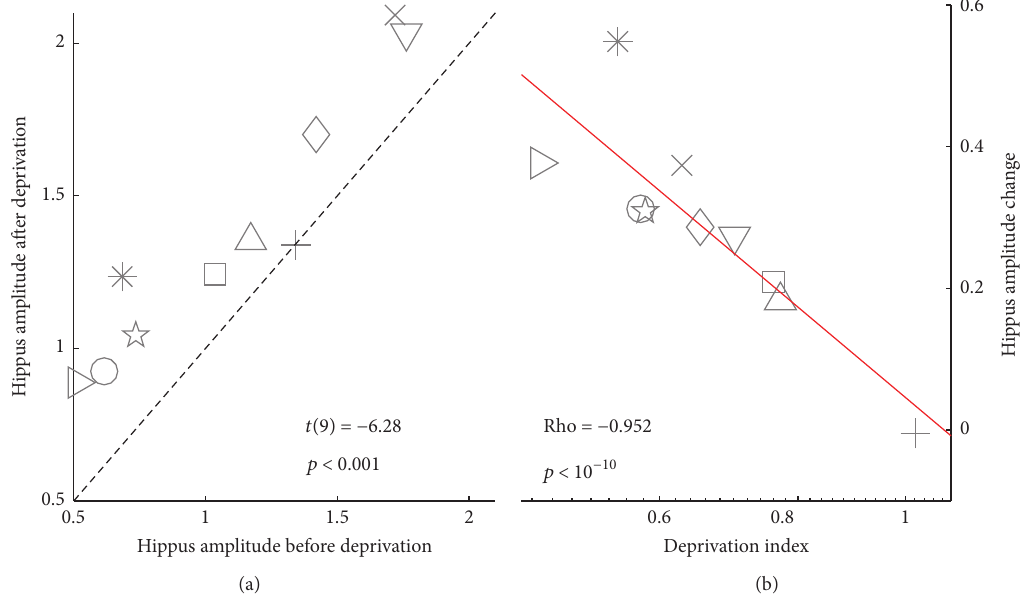
Figure 4: Pupillometry results and correlation with binocular rivalry. (a) Scatter plot of the FFT energy in the 0–0.8 Hz range, measuring the amplitude of the pupil hippus, before deprivation versus 20 minutes after deprivation. The text inset shows the result of a paired 𝑡 -test comparing values on the 𝑥 - and 𝑦 -axis. Similar values are obtained using the alternative preprocessing algorithm (blink removal only: 𝑡 -test comparing before/after hippus amplitude: 𝑡(9) = 6.743 , 𝑝 < 0.001 ). (b) Difference of FFT energy in the hippus range across deprivation, plotted against the binocular rivalry Deprivation Index (see (1)). The text inset shows Spearman’s rank correlation coefficient Rho between values on the 𝑥 - and 𝑦 -axis (note that Spearman’s Rho is insensitive to whether the axes are logarithmic or linear). The thick red line is the best-fit linear function through the data points. Each symbol is one subject, consistent across panels (a)-(b) and with Figure